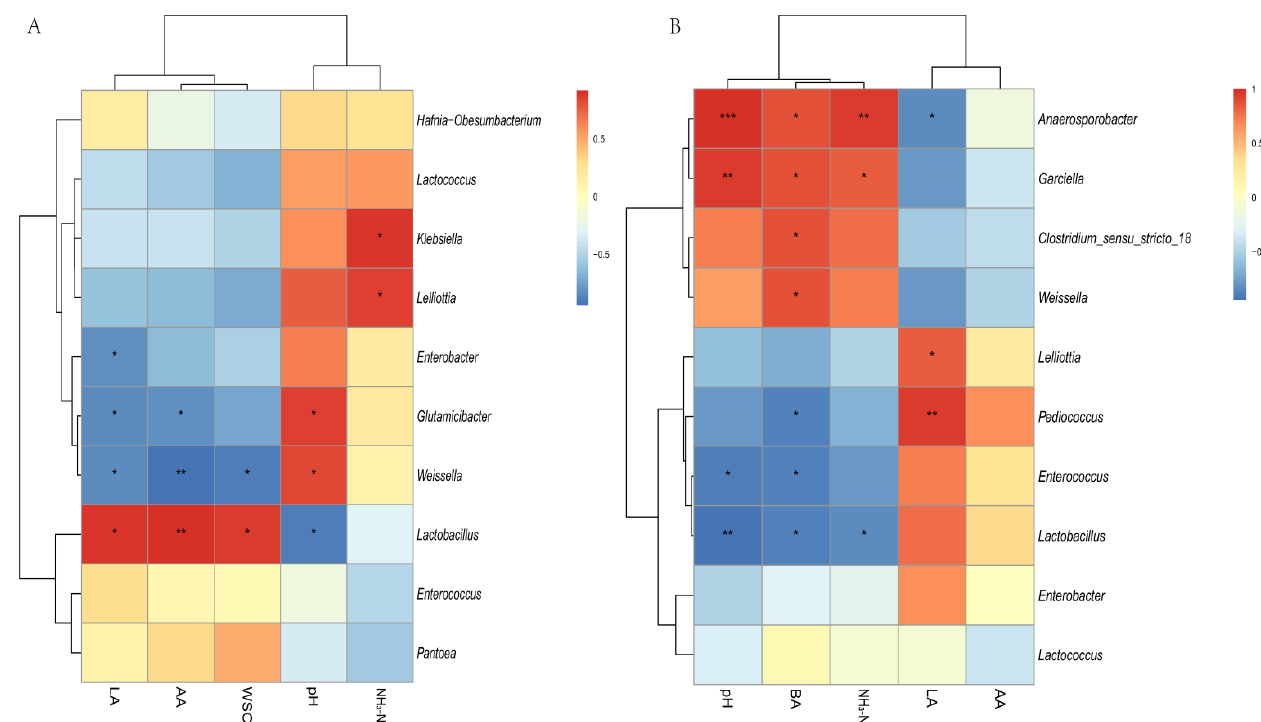
Figure 7. Spearman correlation heatmap of abundance of the top 10 abundant bacterial genera and fermentation properties in alfalfa silage for 15 d ( A ) and 60 d ( B ). LA, lactic acid; AA, acetic acid; BA, butyric acid; NH 3 -N, ammoniacal nitrogen; WSC, water-soluble carbohydrate. * p < 0.05; ** p < 0.01; *** p <